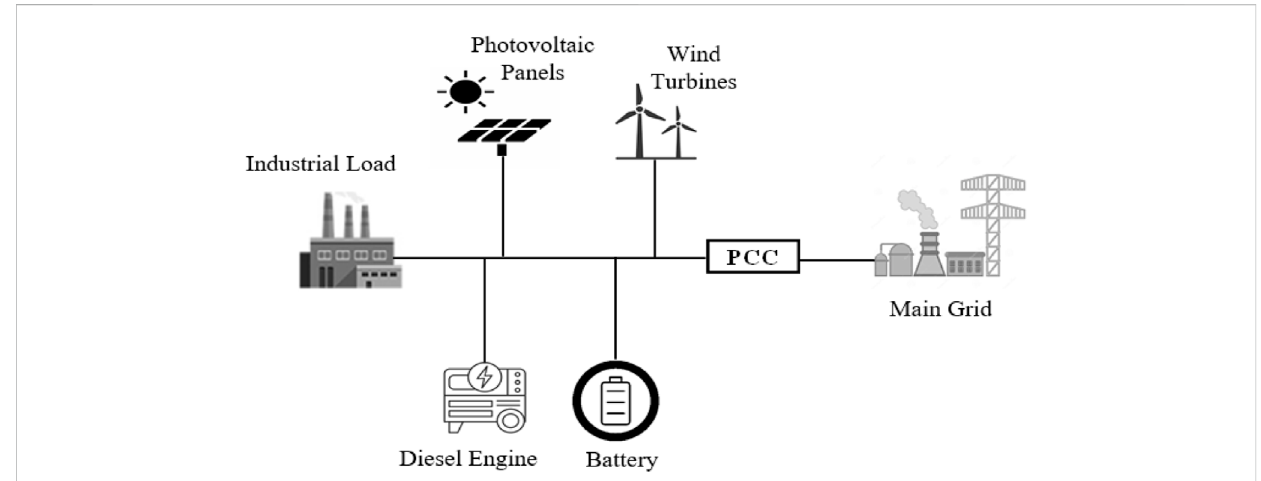
FIGURE 1 Typical microgrid connected to the utility grid for industrial microgrid